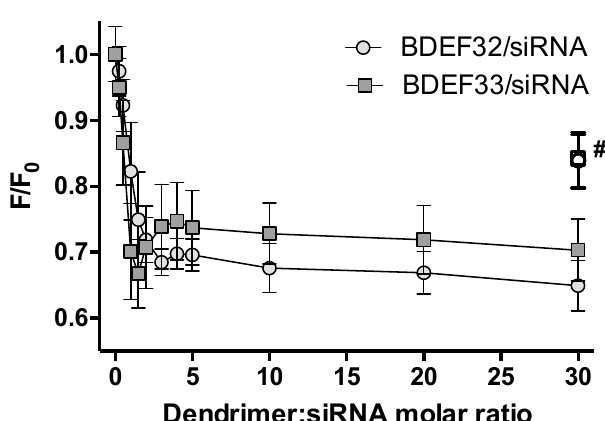
Figure 2. Change of the normalized fluorescence intensity (at 595 nm) of ethidium bromide upon titration of small interfering RNA (siRNA) (0.3 µM siRNA Bcl-xL, 3 µM ethidium bromide (EB)) by carbosilane dendrimers (# marks samples after heparin treatment). Conditions: 1×phosphate-buffered saline (PBS) (10 mM phosphate buffer, pH 7.4, 137 mM NaCl, 2.7 mM KCl), 25 °C.